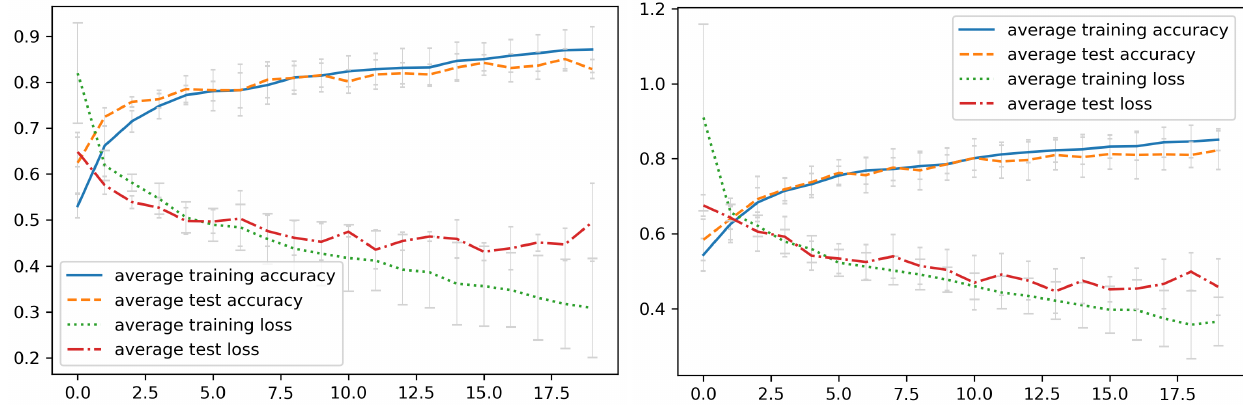
Figure 12. Summary of average results for 20 iterations. Class 0 vs. II. Model: the LeNet model from Figure 5 was applied. Cross-validation 5. Accuracy for 20 iterations of neural network training and corresponding cross-entropy loss.